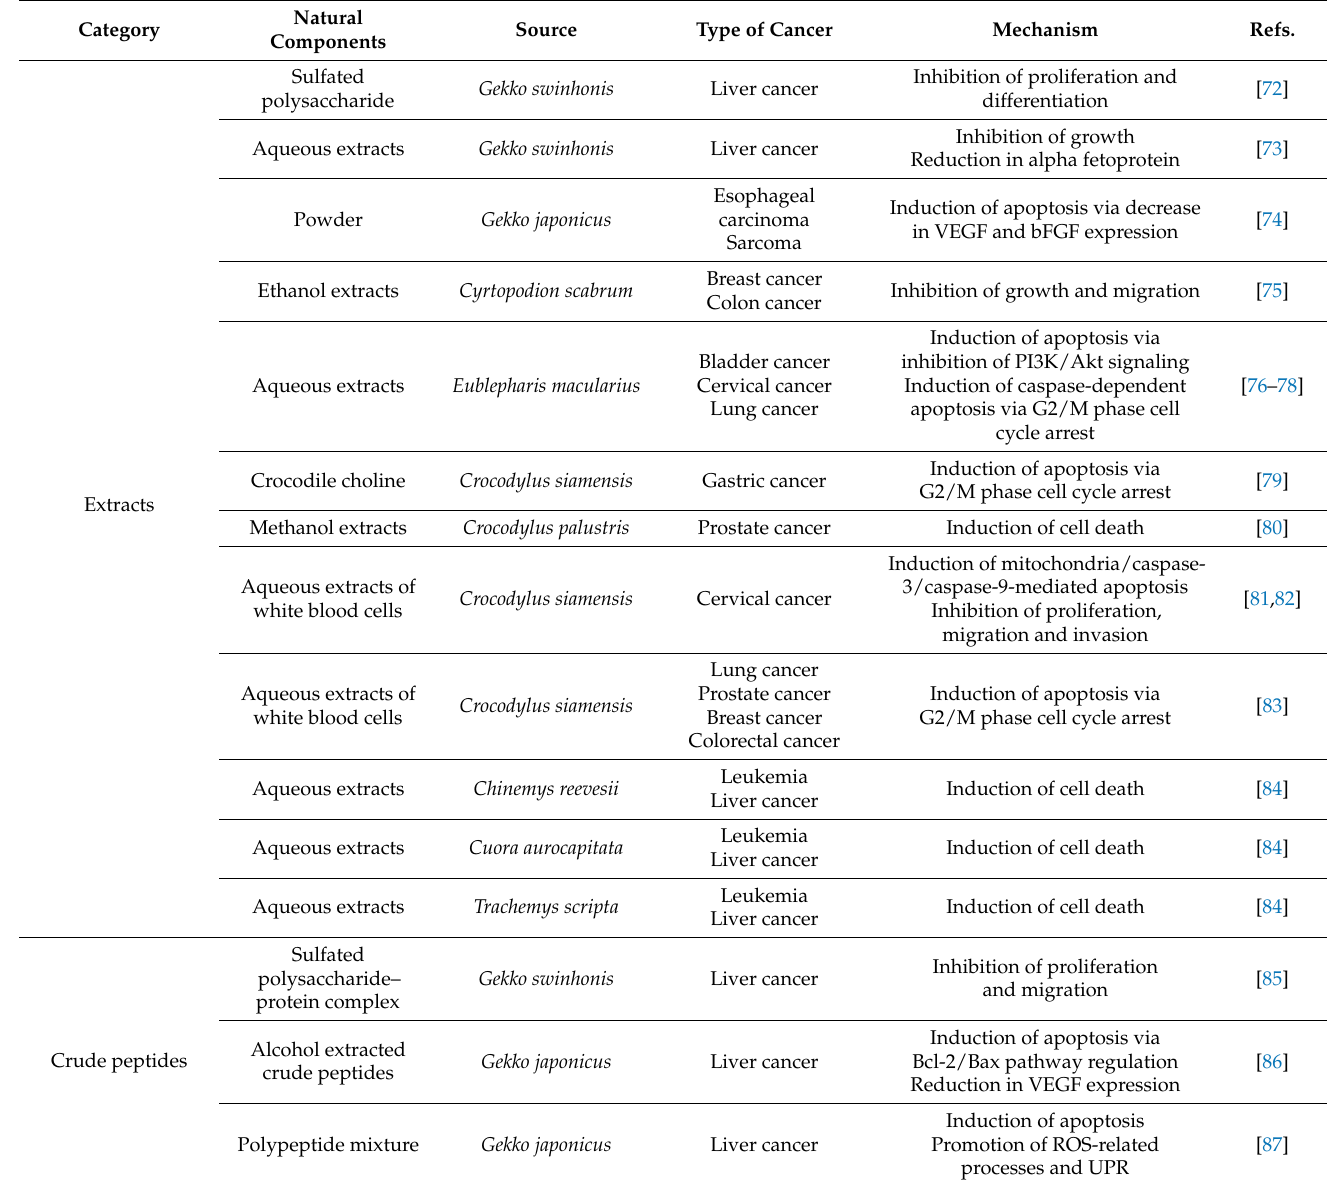
Table 3. The anticancer potentials of reptile-derived